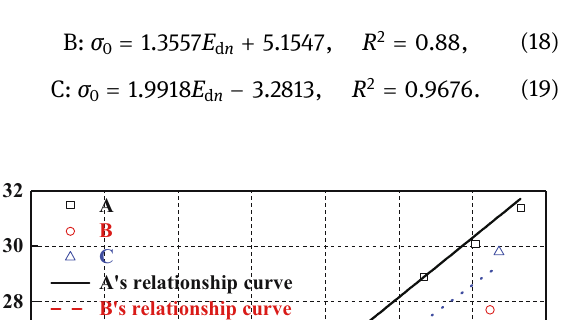
Figure 19: Stress – strain curve fi tting before and after freezing and thawing: ( a ) 0 time, ( b ) 50 time, and ( c ) 125 time.